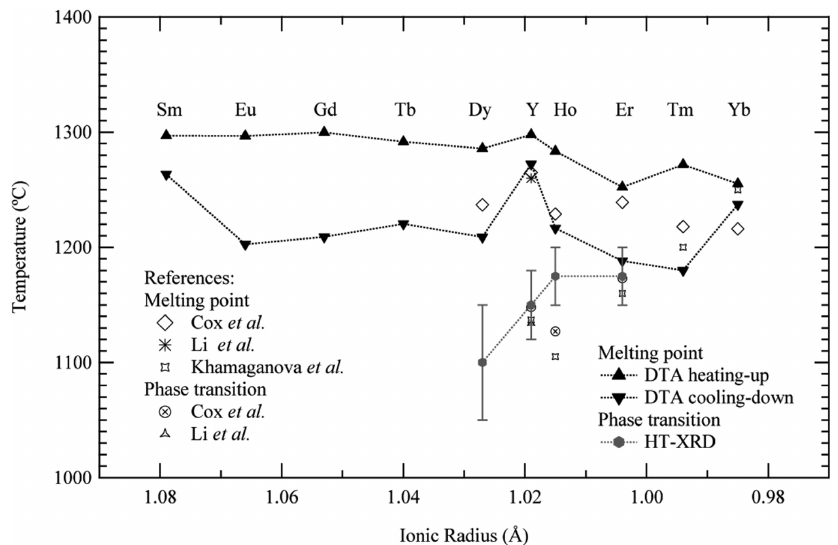
Figure 2: Melting temperatures during heating-up and cooling-down period by DTA and phase transition temperatures during heating-up period by HT-XRD for the Ba 3 R B 3 O 9 system are shown with the published temperatures [2 – 5]. The hori- zontal axis is the effective ionic radius of REE